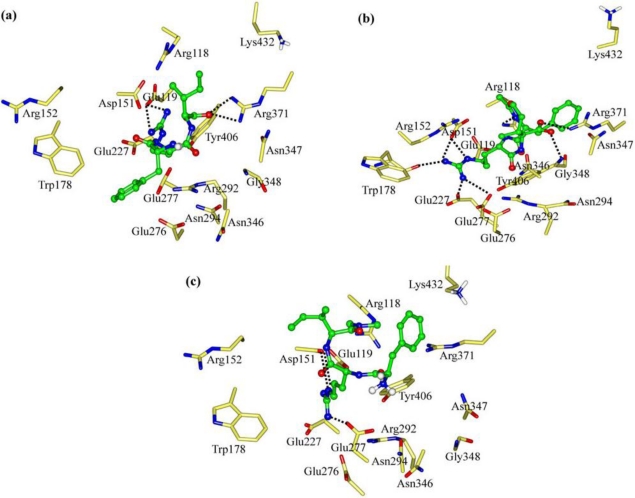
Views of the binding modes of the NA active-site residues with (a) FRIdep, (b) FRIAc and (c) FRIDMA. Key residues are represented by stick models and tripeptides are by ball and stick models. The important H-bonds are labeled as dashed black lines.